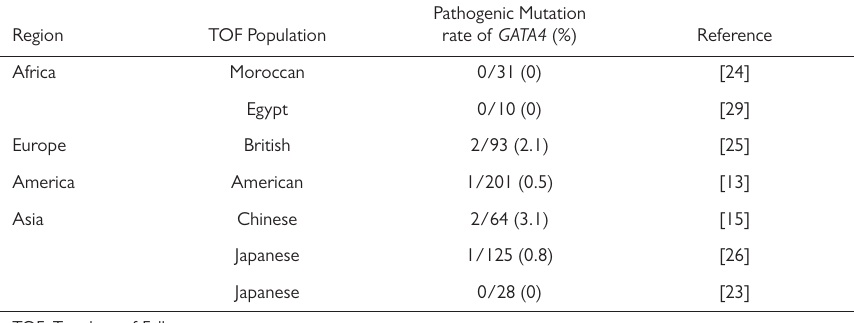
tion. Table 1 and Figure 1 give more details about the features of the detected variants.